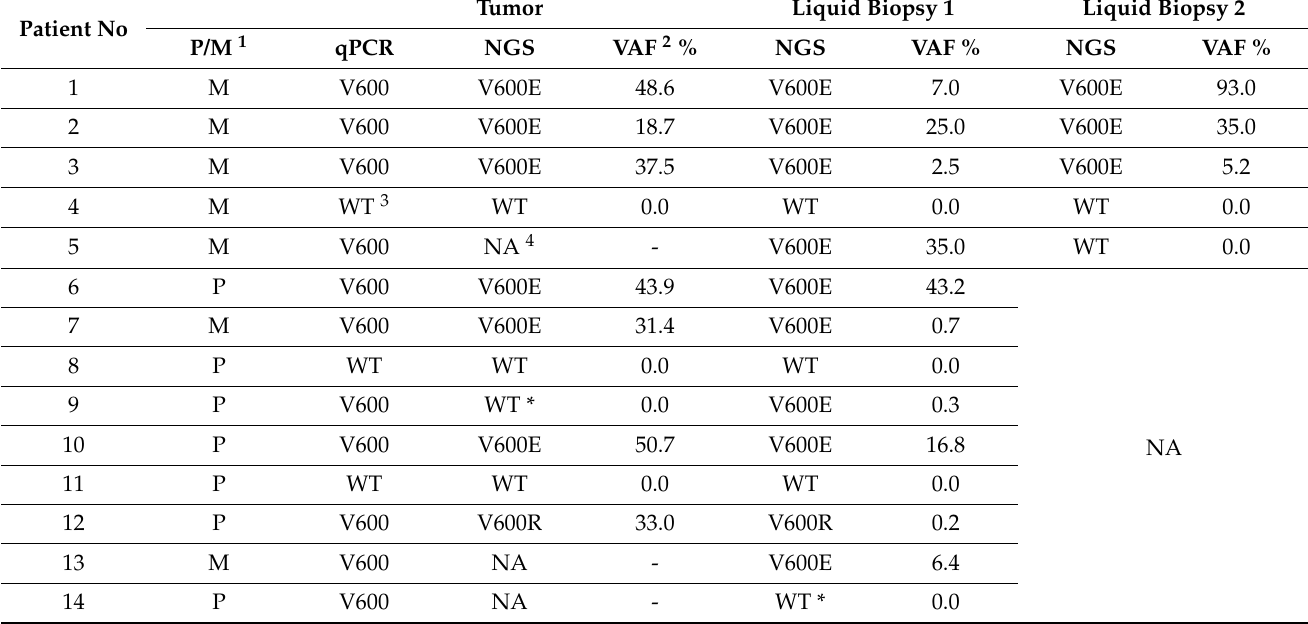
Table 3. BRAF concordance